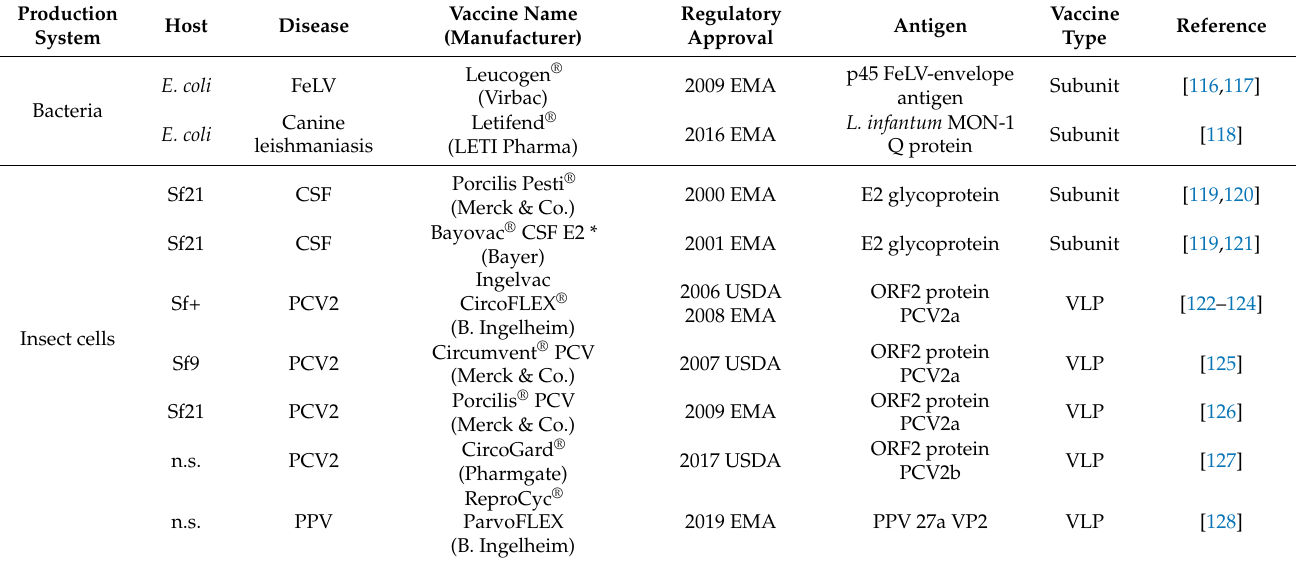
Table 2. Recombinant protein vaccines approved for veterinary